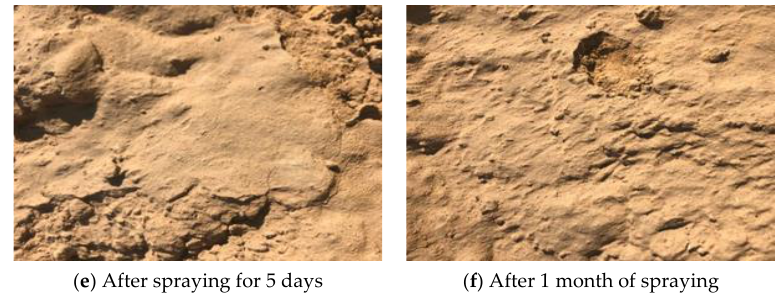
Figure 11. Comparison diagram before and after spraying dust inhibitor.